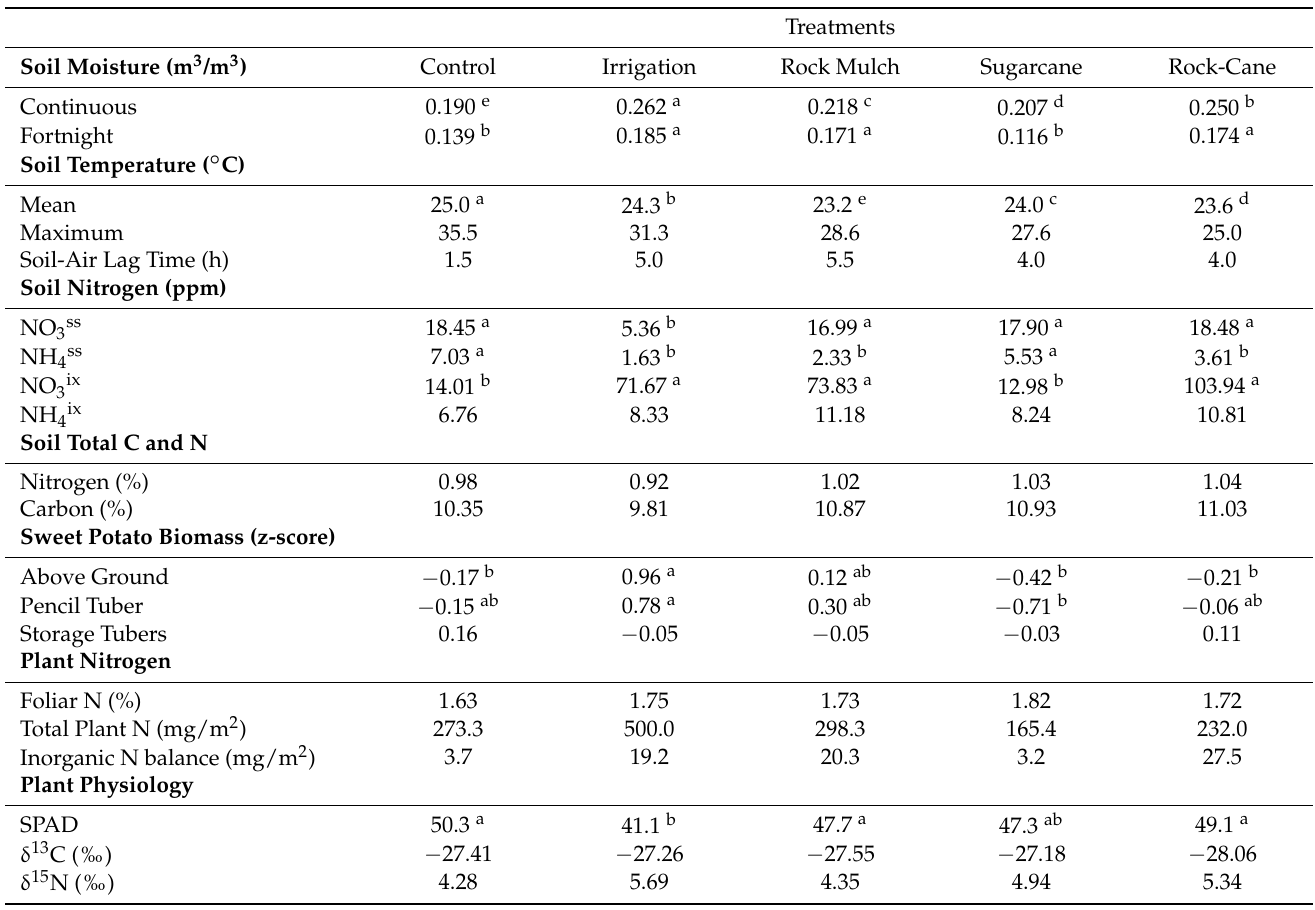
Figure 3. Mean soil temperature of treatments across Sites during growing season of sweet potato. Table 2. Mean parameters of core data by treatments across study sites. Where relevant, connecting letters are used to indicate significant differences as determined by Tukey